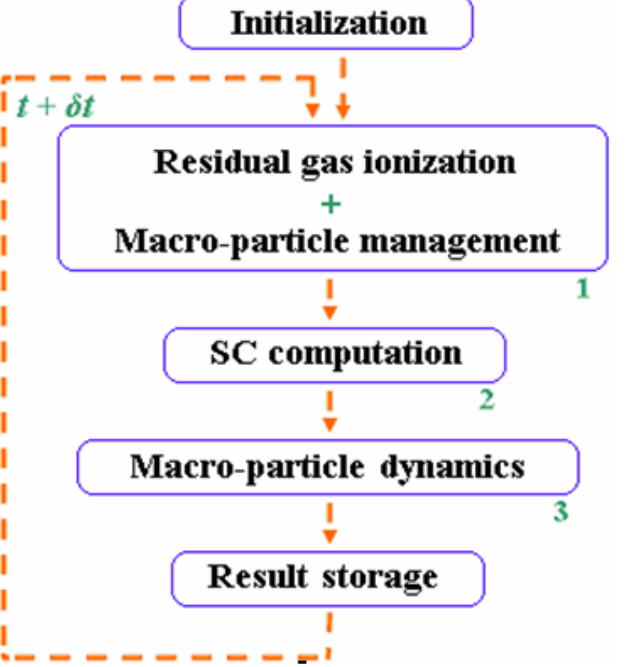
FIG. 1. (Color) CARTAGO algorithm.